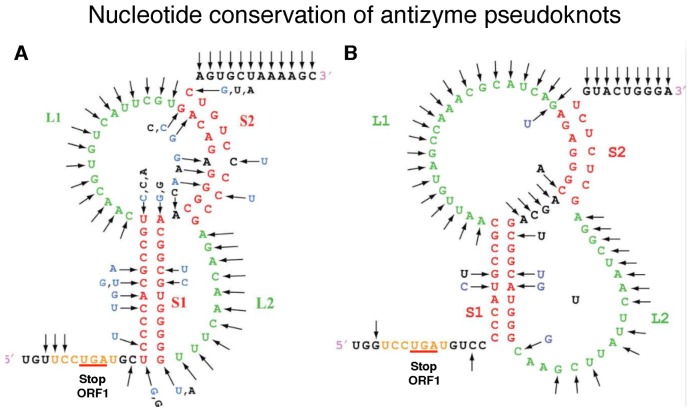
Sequence variability of antizyme frameshift stimulatory pseudoknot single-stranded regions contrasts with that involved in stem formation. The illustration is from pseudoknots from invertebrates (an oyster and an aphid) that differ from their mammalian counterparts. (A) Crassostrea gigas, (B) An aphid. The frameshift site is indicated with orange letters. Black arrowheads represent substitutions deduced from phylogenetic comparison to orthologous genes. Non-compensatory changes in the stems are shown in black letters; compensatory changes are shown in blue letters.